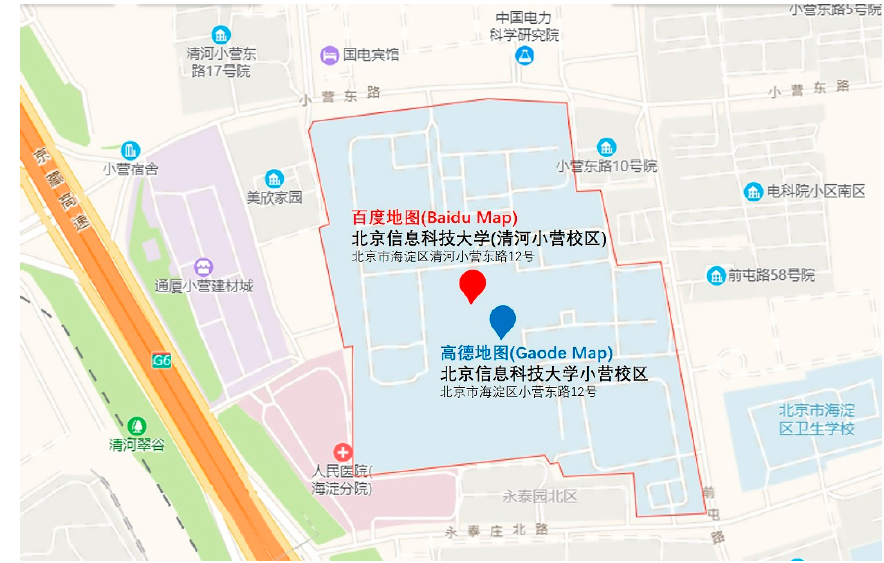
Figure 1. A pair of corresponding entities from different sources (Gaode Map and Baidu Map).